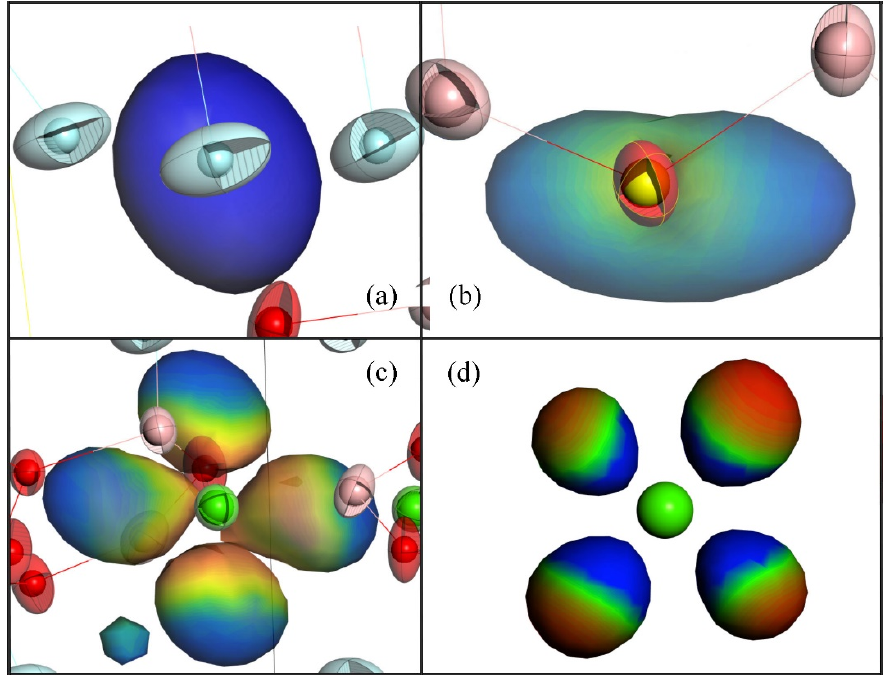
Figure 4. The wave function distributions of the orbitals at the positions of ( a ) − 24.165, ( b ) − 20.763, ( c ) 0, and ( d ) 6.984 eV in the DOS of CBOF (isosurface from 1.747 × 10 − 4 to 0.056 for drawing the pictures).